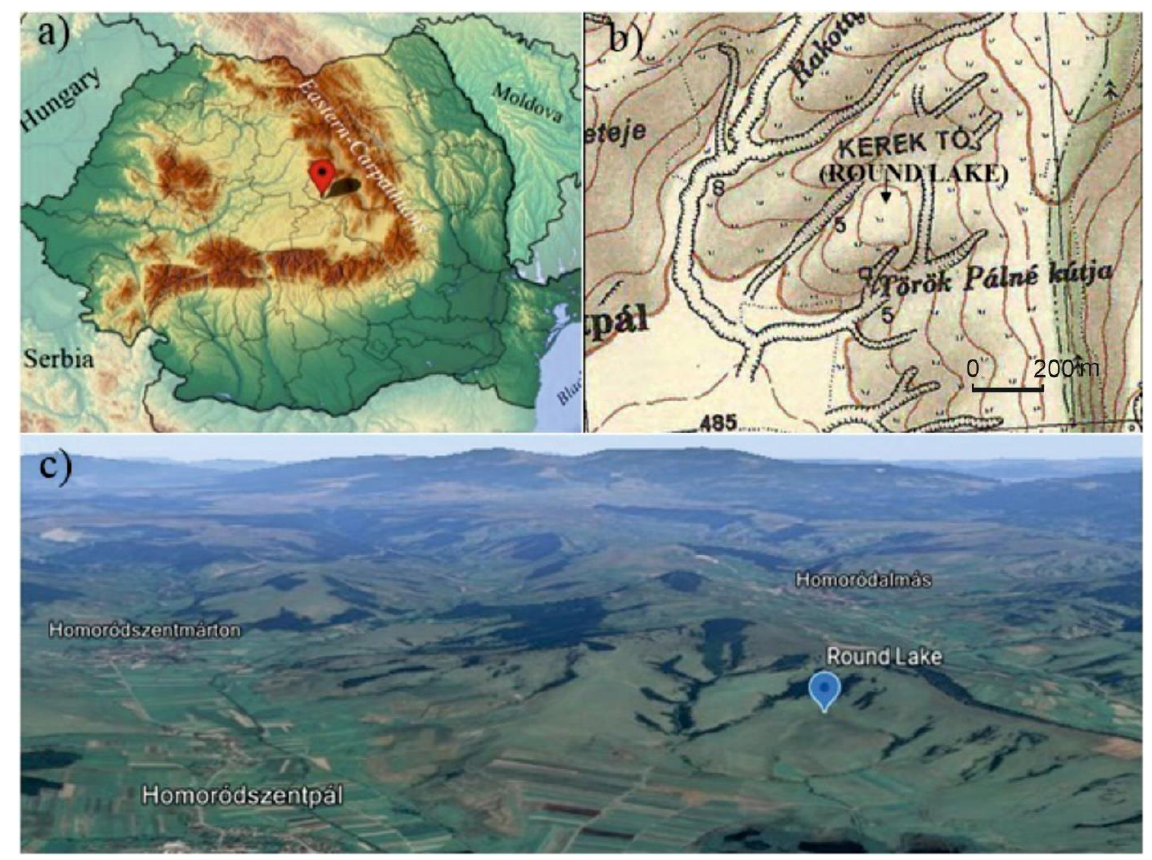
Figure 1. Map of Romania within the studied site Round Lake at Sănpaul (edited by Réka Orsolya Tapody adapted from: mapsland.com and Google Maps—accessed on 30 April 2021). ( a ) The location of the site in Romania ( b ) The vicinity of the site in a topographic map (which is roughly 1 × 1 km); ( c ) and in an aerial view (the distance of the site and Homoród-szentpál (Sânpaul) is 2 km)